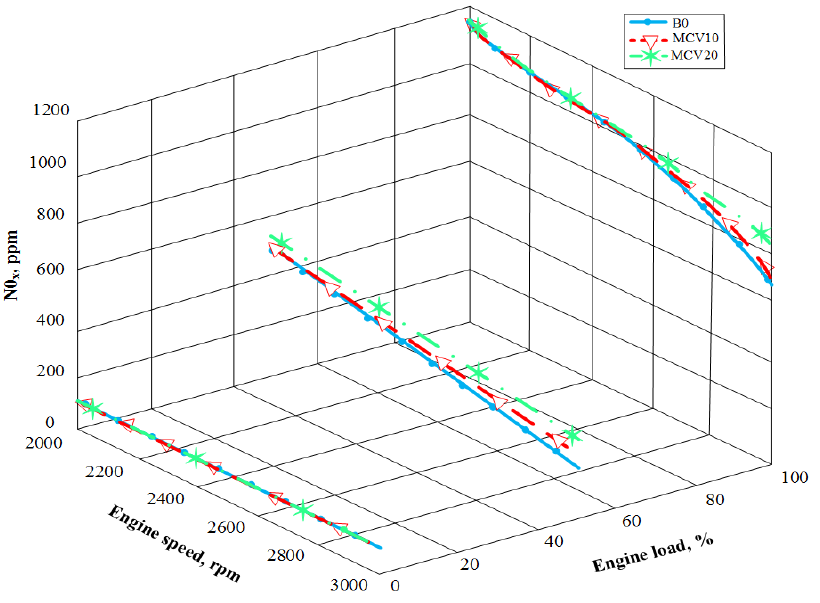
Fig. 8. NO x emissions of MCV biodiesel blends at different